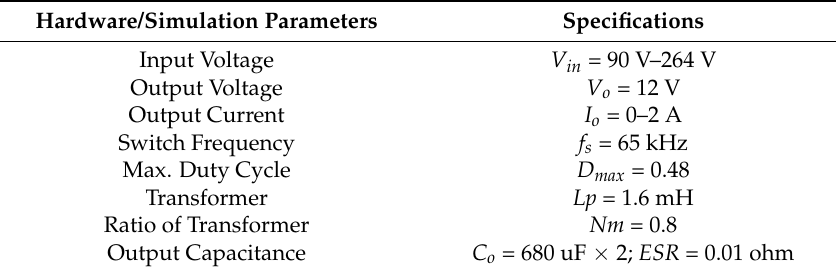
Table 2. Hardware and specifications.